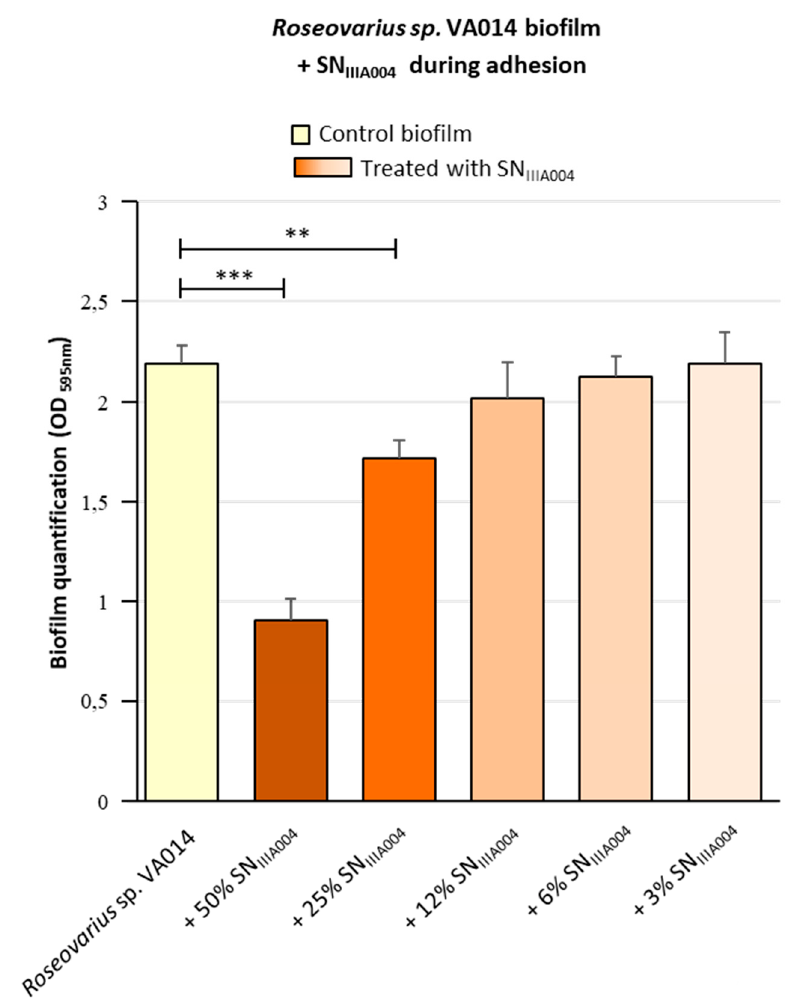
Figure 1. E ff ect of SN IIIA004 on the Roseovarius sp. VA014 biofilm formation in microtiter plate. Roseovarius sp. VA014 was mixed for 2 h with serial dilutions of SN IIIA004 in 96-well microplates during the adhesion step. The Roseovarius sp. VA014 biofilms were then grown at 22 ◦ C for 24 h. The standard deviations were calculated from 3 replicates. Control biofilm: Roseovarius sp. VA014 biofilm treated with Zobell broth instead of SN IIIA004 . Each biofilm treated with a culture supernatant was compared with the control biofilm. Significant di ff erences are indicated by ** ( p < 0.01) or *** ( p <